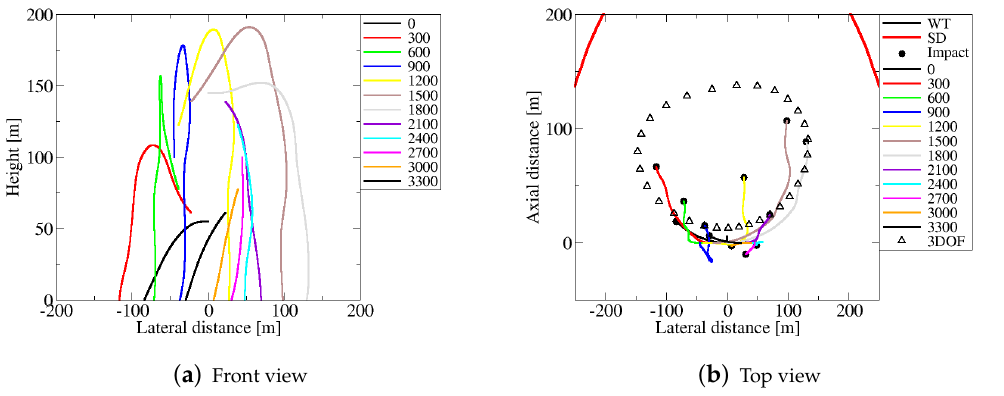
Figure 15. Trajectories from a rotating wind turbine. Computations based on